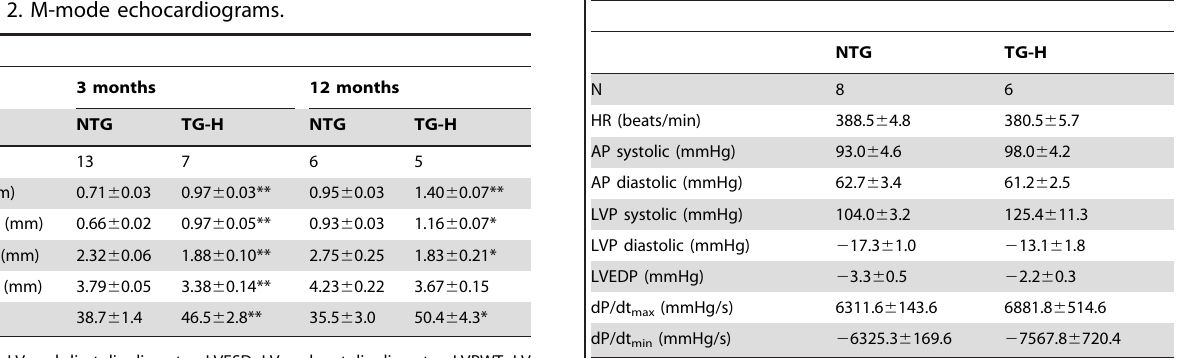
Table 3. Hemodynamic Analysis of TNNI3K Transgenic